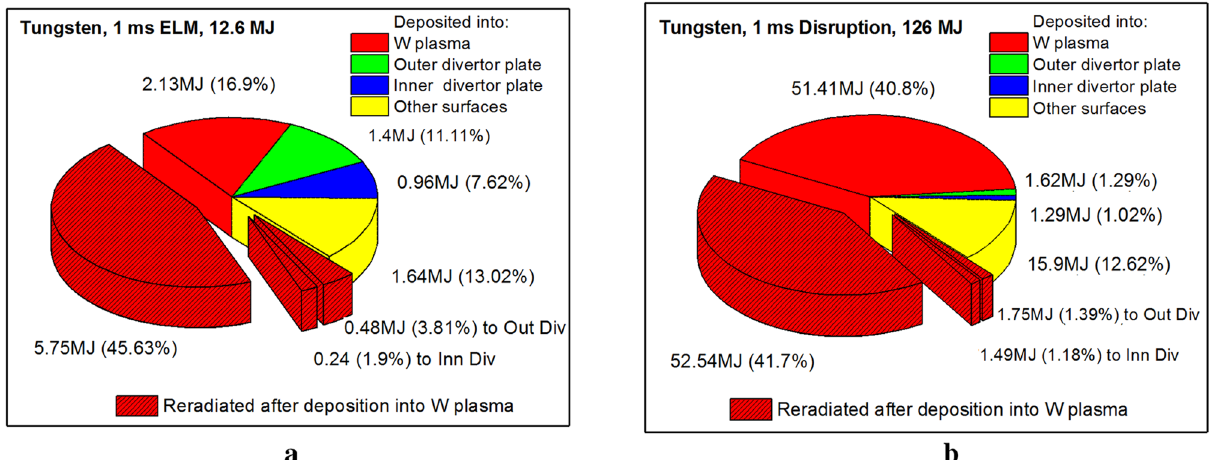
Figure 2. HEIGHTS predictions of the final energy balance in ITER transient events with tungsten SP: 1.0 ms ELM ( a ), and 1.0 ms disruption ( b ). The images were prepared using OriginPro